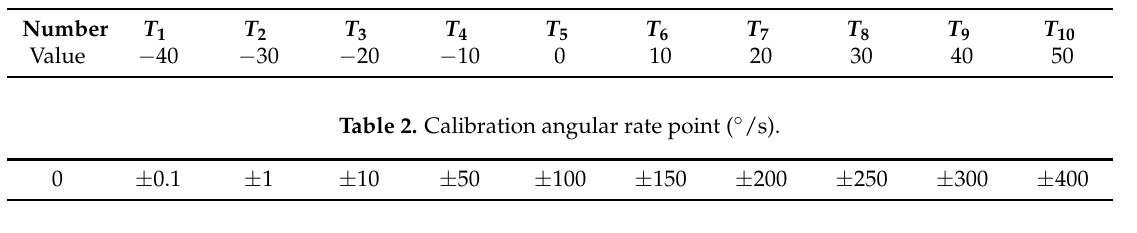
Table 1. Calibration temperature point ( ◦ C).